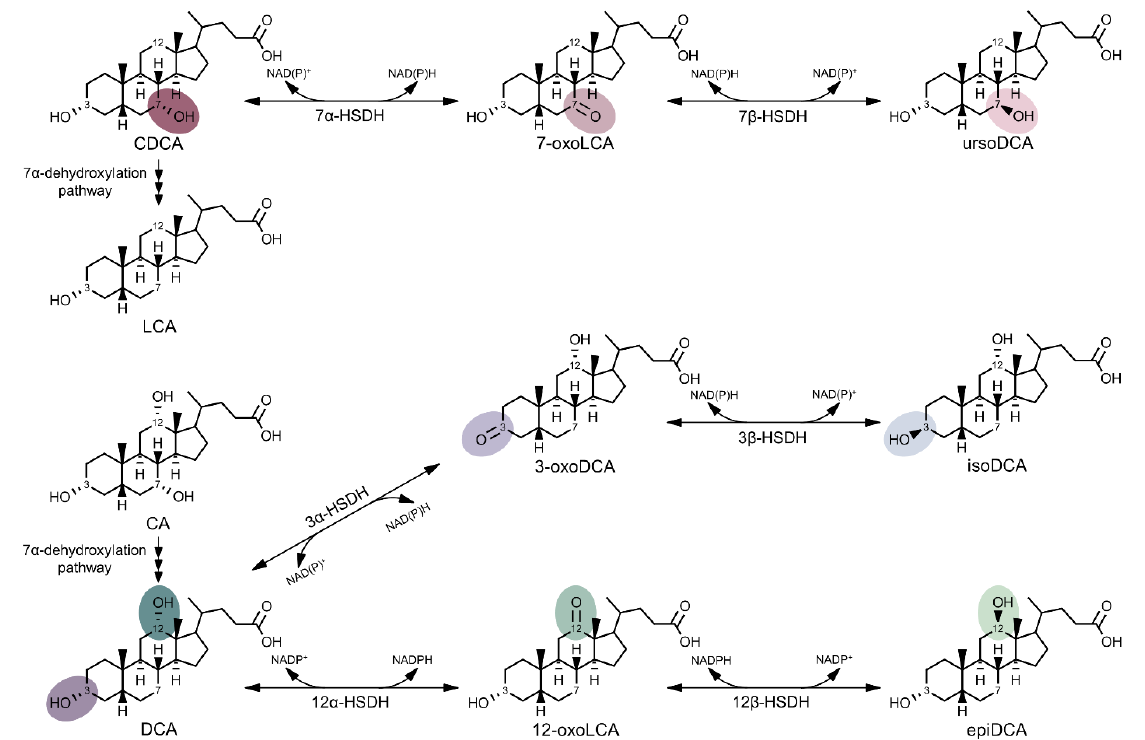
Figure 3. Microbial bile acid hydroxysteroid dehydrogenase metabolism. After deconjugation by bile salt hydrolase, the primary bile acids (BAs) chenodeoxycholic acid (CDCA) and cholic acid (CA) can be 7 α -dehydroxylated or reversibly biotransformed by NAD(P)(H)-dependent hydroxysteroid dehydrogenases (HSDHs). CDCA is converted to the oxo-intermediate, 7-oxolithocholic acid (7-oxoLCA), and further to ursoDCA (UDCA) in the urso-BA pathway catalyzed by 7 α - and 7 β -HSDH. The secondary BAs lithocholic acid (LCA) and deoxycholic acid (DCA) are produced through the multi-step 7 α -dehydroxylation of CDCA and CA, respectively. 3 α -HSDH biotransforms DCA into 3-oxoDCA, and 3 β -HSDH converts 3-oxoDCA to isoDCA in the iso-BA pathway. DCA is converted to 12-oxoLCA by 12 α -HSDH and from 12-oxoLCA to epiDCA by 12 β -HSDH. HSDHs can recognize other BAs with the correct hydroxyl group position and orientation beyond those